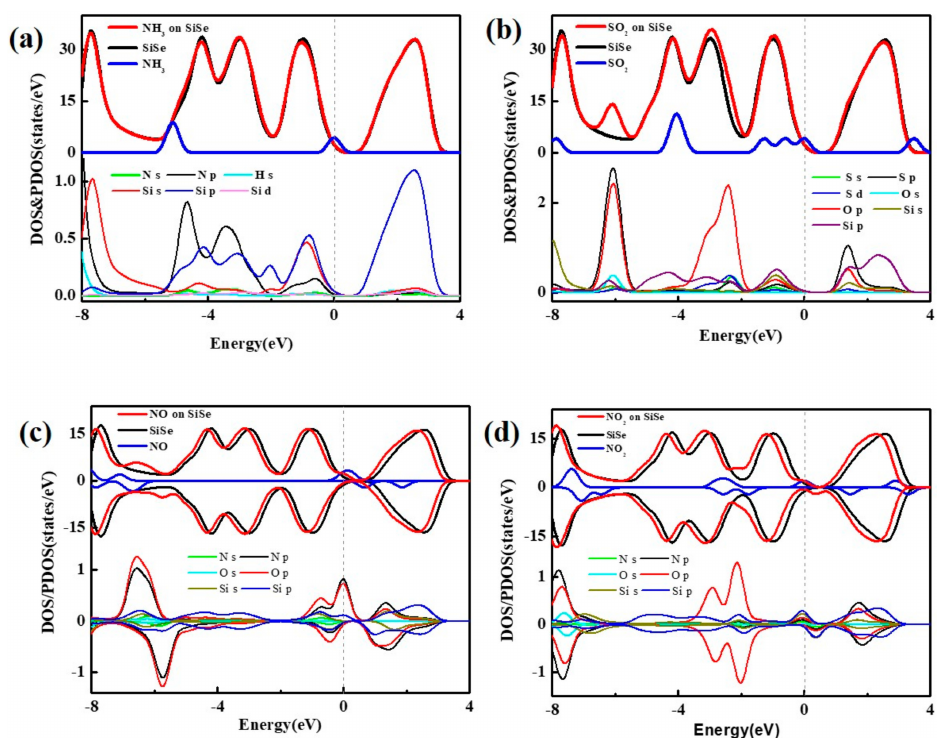
Figure 4. The DOS and PDOS maps of ( a ) NH 3 , ( b ) SO 2 , ( c ) NO, and ( d ) NO 2 molecules adsorbed on SiSe